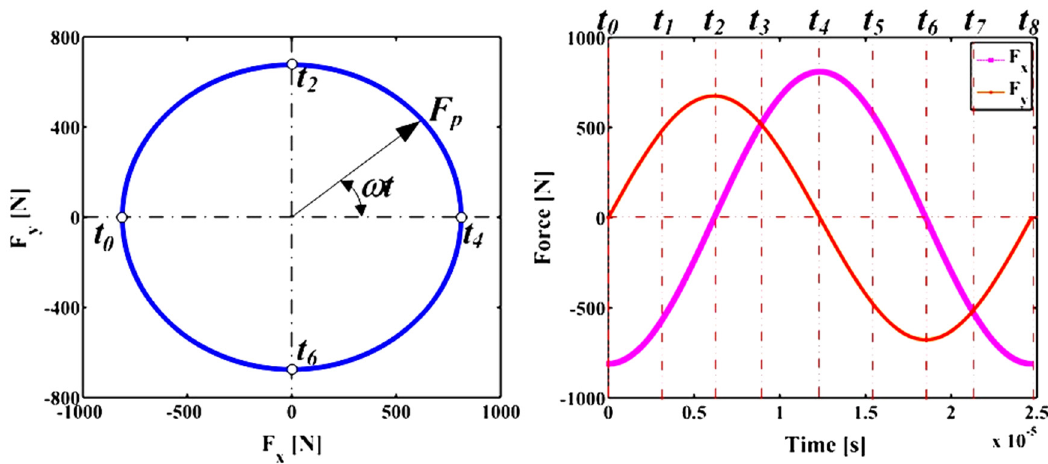
Figure 11. Dynamic force components in the vertical and horizontal directions for a period of contact.